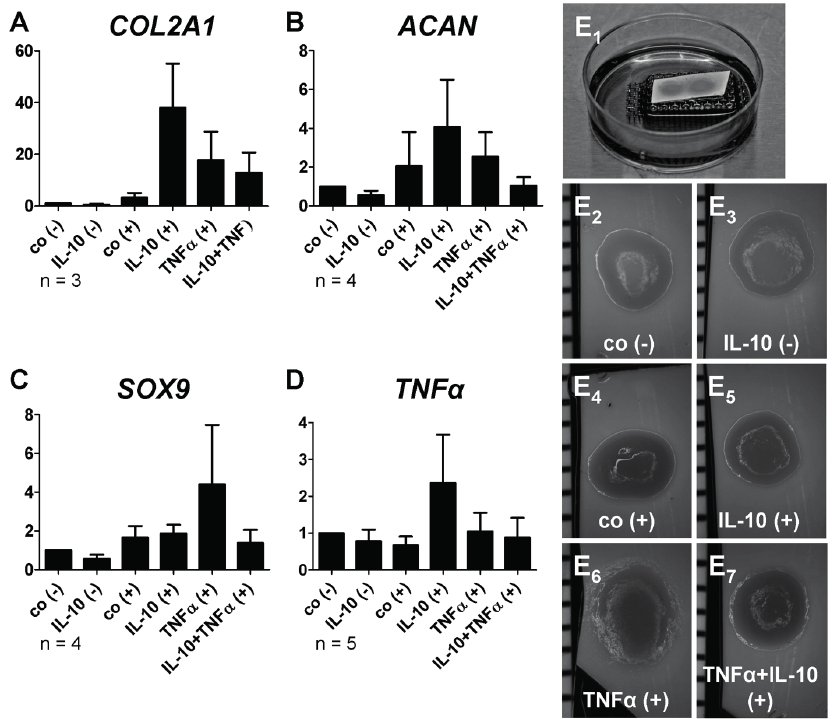
Figure 6. Relative gene expression of cartilage markers in H-D cultures after 14 days of differentiation and 7 days cytokine stimulation. The H-D cultures were differentiated for 14 days and stimulated during the last 7 days with either IL-10 or TNF α alone, or in combination (each 10 ng/mL). COL2A1 ( A , n = 3) and ACAN ( B , n = 4) encodes main structural components of articular cartilage; SOX9 ( C , n = 4) encodes one of the most important transcription factors during chondrocyte differentiation, whereas TNF α ( D , n = 5) encodes a pro-inflammatory cytokine; ( E – E ) Representative macroscopic images of the 1 7 14 day old H-D cultures after treatment. Data was normalized. ( A – C ) The number of experiments did not allow approving a Gaussian distribution of the data. Therefore, a Wilcoxon signed rank test was performed. p < 0.05; ( D ) A Gaussian distribution could be determined for the data hence one-sample- t -test, one way ANOVA and Bonferoni post test were used. n = 3–5 independent experiments with cells of different donors were